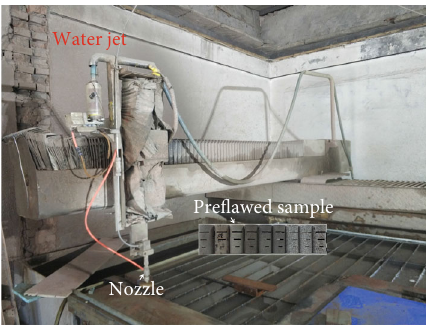
Figure 2: Production of the granite samples with two preexisting fl aws for the fatigue mechanical test.